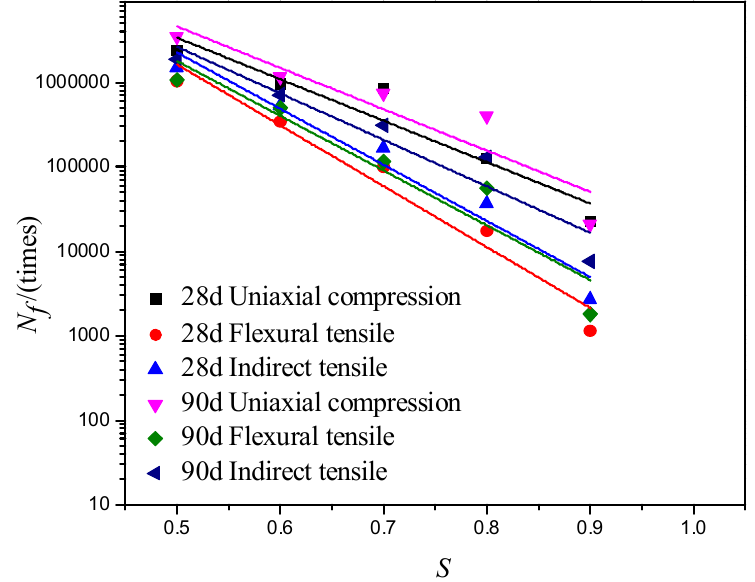
Figure 7. Fitting curve for the fatigue equation for a cement content of 4% under different stress states.